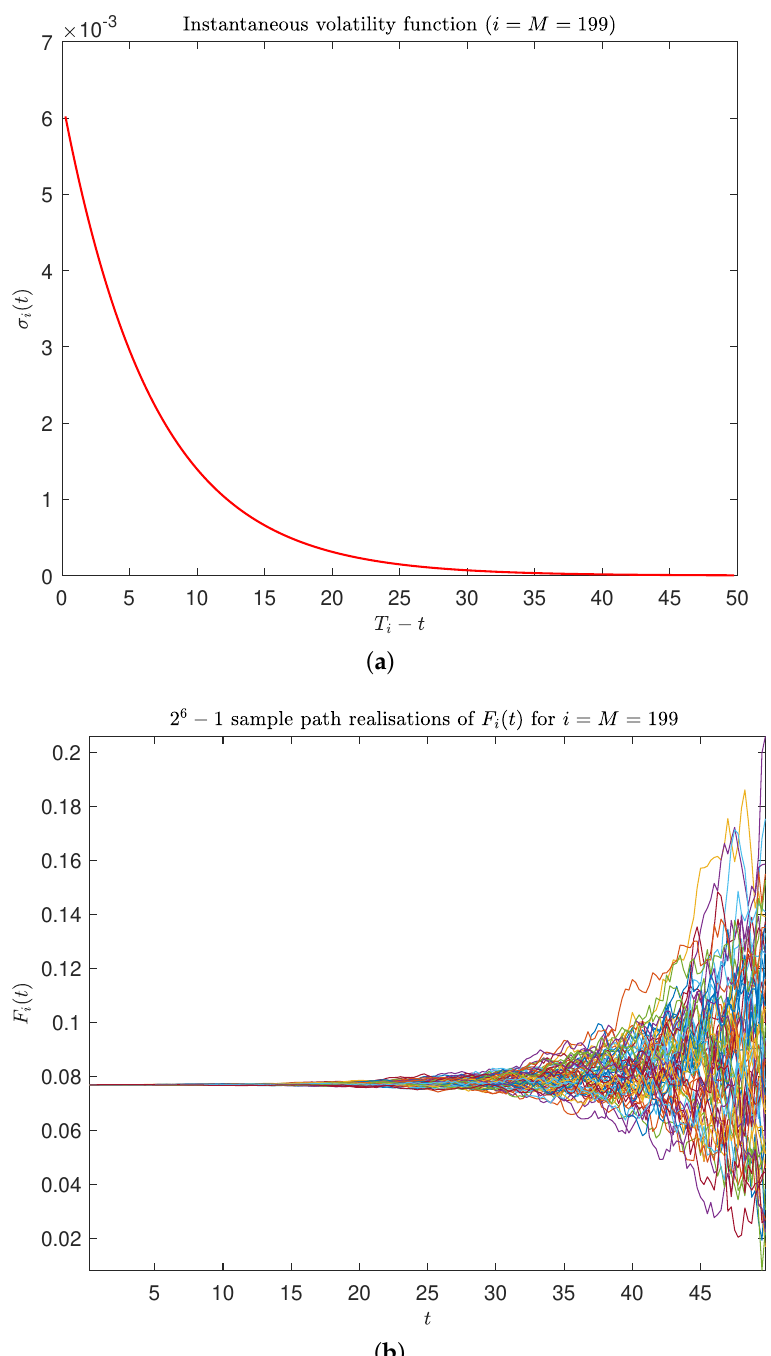
Figure 2. Illustrating the evolution of F i ( t ) with a time-homogeneous exponentially decaying instan- taneous volatility function under the discretized Vasiˇcek model. ( a ) Visual representation of (29). ( b ) Sample path realisations of F i ( t ) , for i = M =